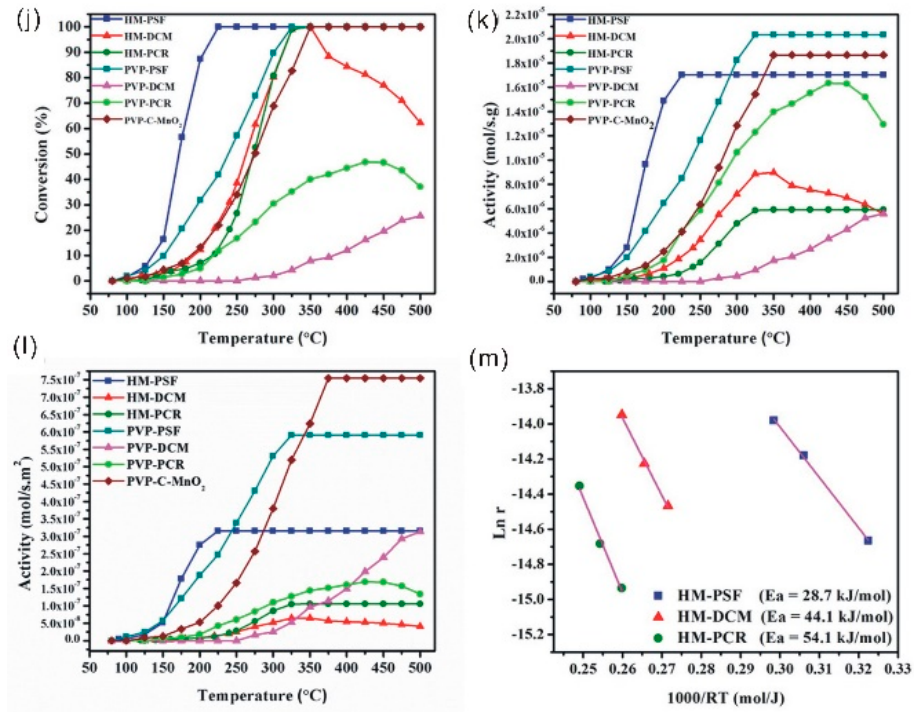
Figure 9. SEM images of manganese oxide nanorod arrays on the cordierite substrate: ( a ) top view and ( d ) cross-sectional view of K 2 Cr 2 O 7 (HM-DCM); ( b ) top view and ( e ) cross-sectional view of KClO 3 (HM-PCR); ( c ) top view and ( f ) cross-sectional view of K 2 S 2 O 8 (HM-PSF). SEM images of as-synthesized manganese oxide powders collected from each reaction: ( g ) HM-DCM; ( h ) HM-PCR; ( i ) HM-PSF; ( j ) Catalytic performance of manganese oxide nano-array-based and dip-coated monolithic catalysts for CO oxidation; ( k ) Calculated activities as a function of the temperature; ( l ) Calculated activities normalized by the surface area as a function of the temperature; ( m ) Arrhenius plot of the reaction kinetics and calculated activation energies. Reprinted with permission from [25], Copyright ACS,